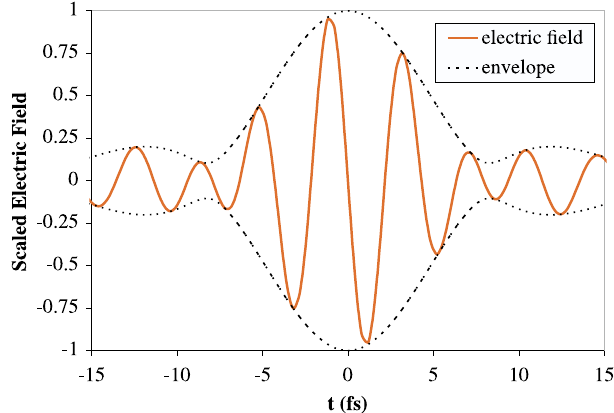
FIG. 5. (Color) The electric field of the two lasers as a function of time, superimposed where the electric field from each laser vanishes at the midpoint. The envelope of the waveform is also shown (dashed line).